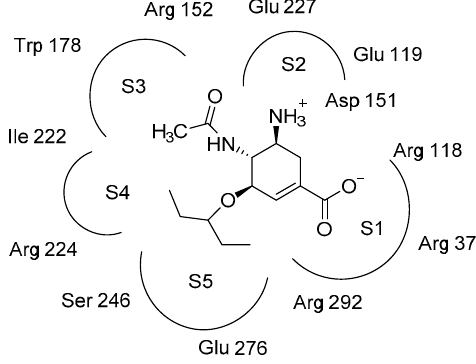
Figure 1. 2D diagram of S1–S5 of the active site with oseltamivir carboxylate (OC).